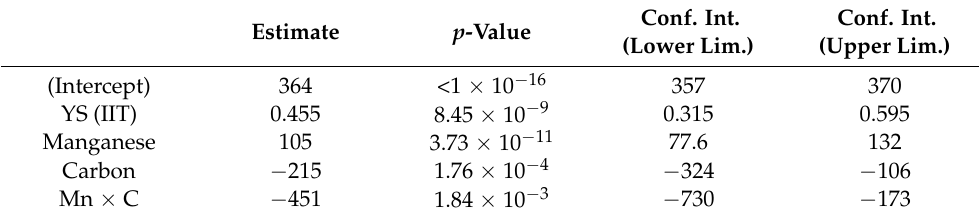
Figure 10. Unity plots comparing estimated versus observed YS with 95% confidence interval (gray shaded region) and 95% prediction interval (blue shaded region) for ( a ) IIT-only and ( b ) IIT + Composition. Table 3. YS IIT + Composition model; regression coefficients and parameters (coefficients appear in Equation